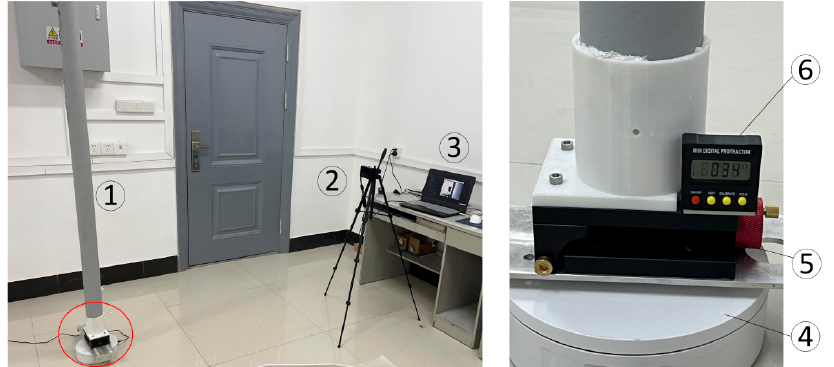
Figure 18. The experimental environment of the simulated pole. Where, 1. pole model, 2. depth camera, 3. image processing system, 4. rotating platform, 5. inclined platform, and 6. angle measur- ing instrument.